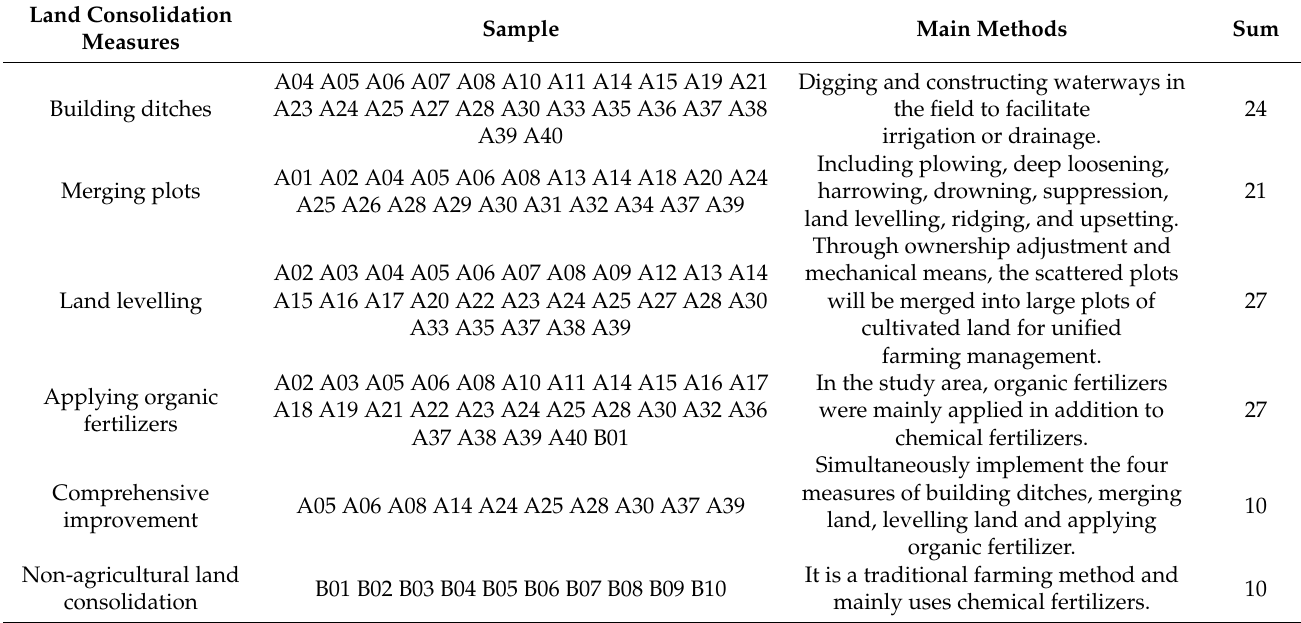
Table 1. Layout of sample